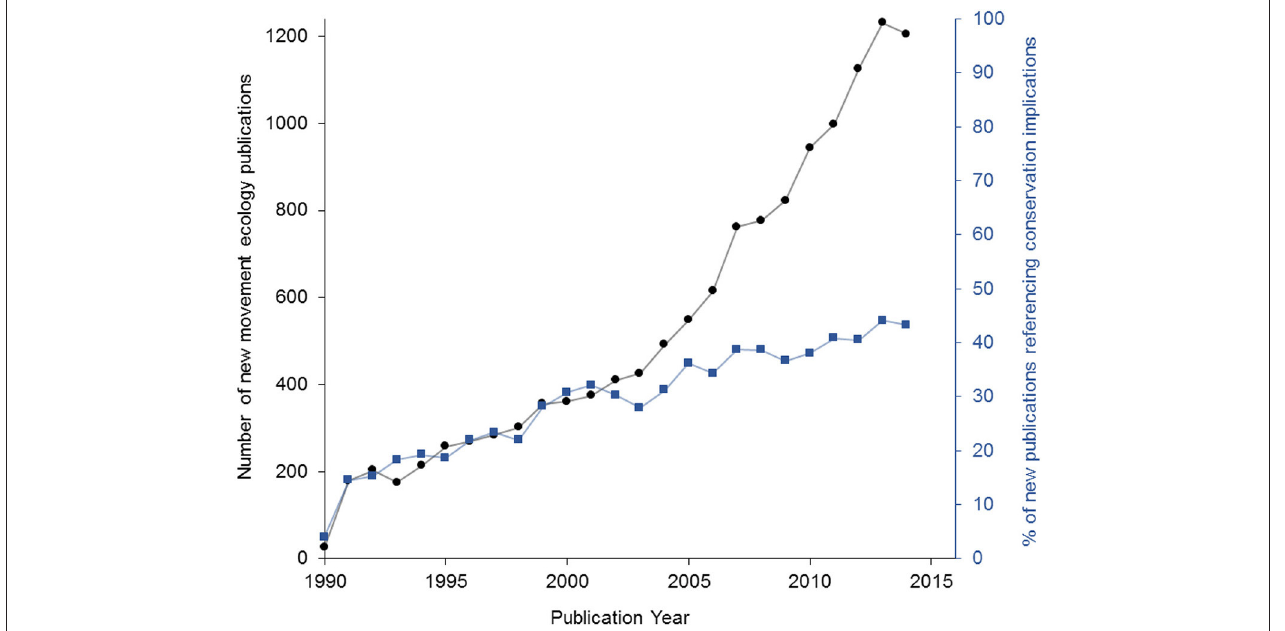
FIGURE 1 | Annual number of peer-reviewed publications addressing movement ecology has increased steadily since 1990 (shown in black; y-axis on left), along with the percentage of those publications that also address species conservation, management, protection, and/or recovery (shown in blue; y-axis on